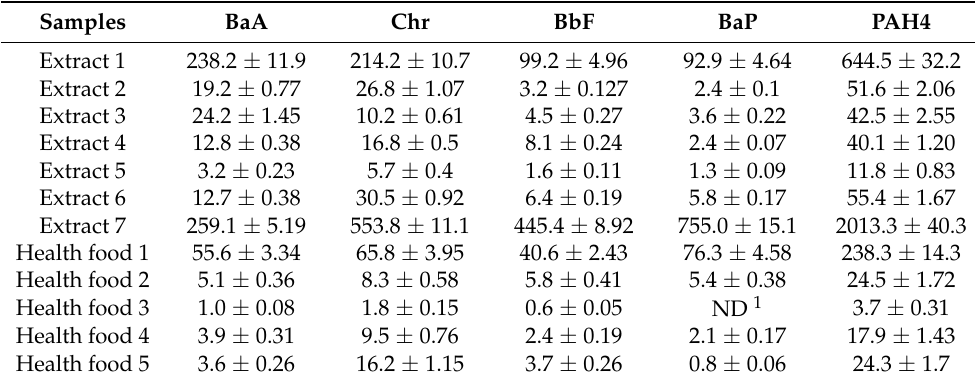
Table 3. PAH4 content of 12 samples containing CMRM extracts ( µ